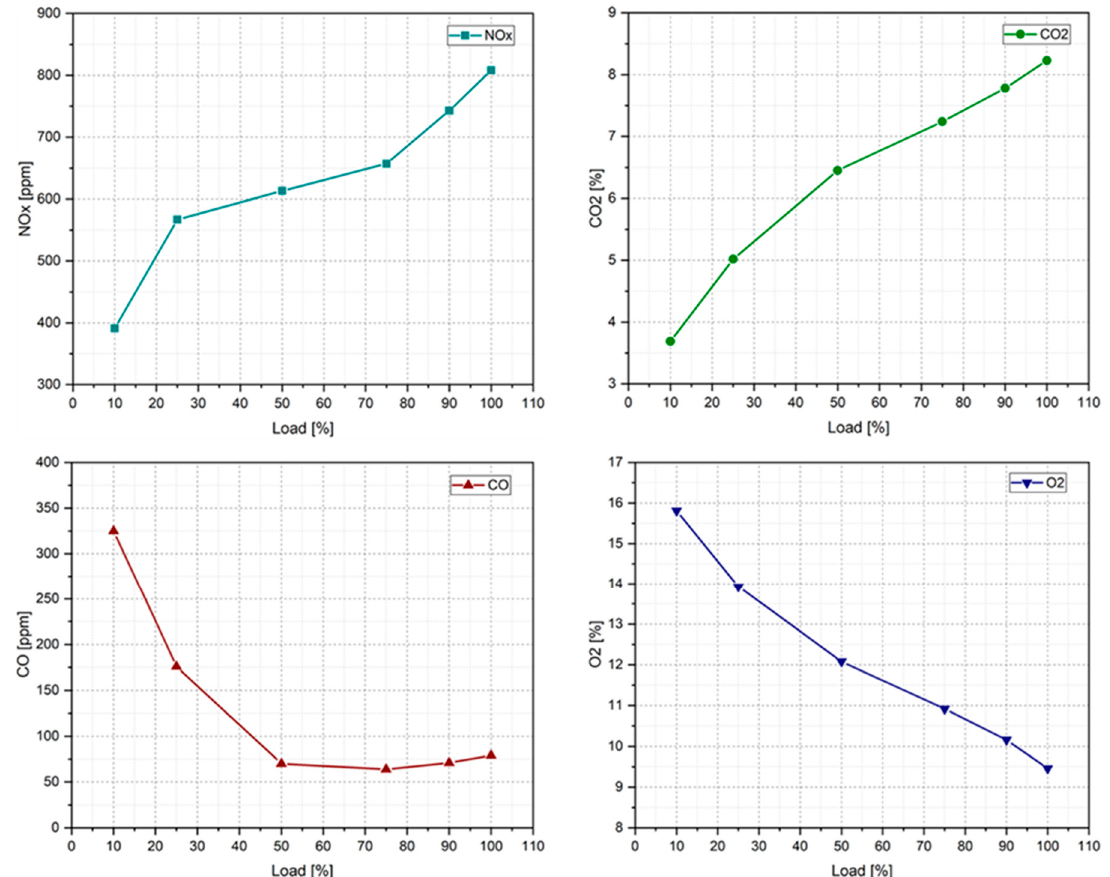
Figure 6. Species concentration analysis when changing the engine load at the rated